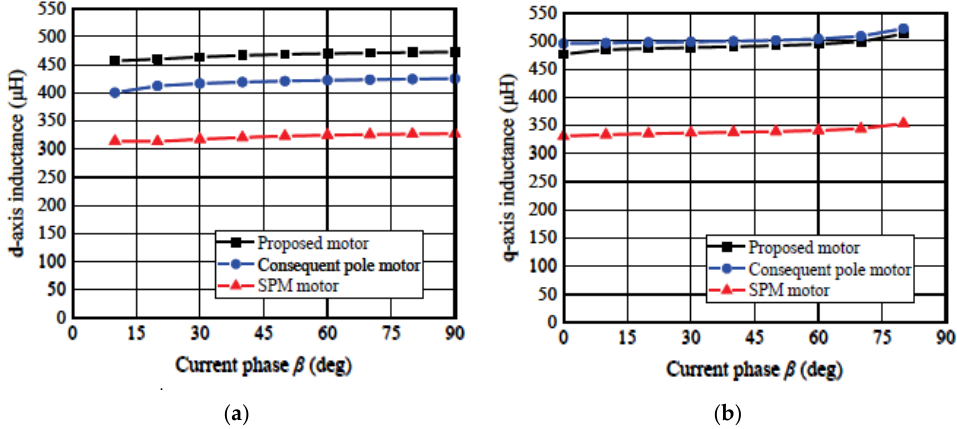
Figure 29. Comparison of inductance: ( a ) d-axis inductance; ( b ) q-axis inductance.